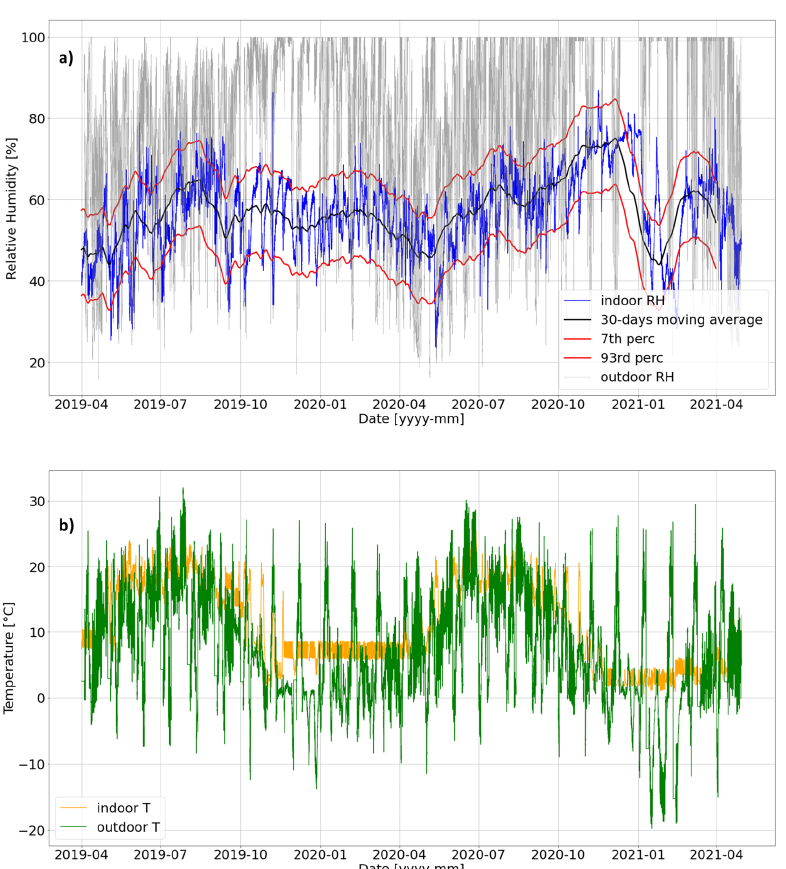
Figure A2. Microclimatic timeseries collected inside and outside Heddal church from the end of March 2019 to the end of April 2021: ( a ) outdoor RH (grey), indoor RH (blue), moving average of RH (black) and percentiles (red) of RH fluctuations computed according to [4]; ( b ) outdoor T (green) and indoor T (orange). Figure A2a shows the measured indoor RH (blue curve), its moving average (MA) calculated over 30 days (black curve) and the 7th (bottom red curve) and 93rd (top red curve) percentiles of the RH fluctuations for Heddal church, calculated according to [3], over two years of observation (from 30 March 2019 to 30 April 2021). In addition, the out- door RH is plotted with a light-grey curve. Figure A2b shows the indoor T (orange curve) and the outdoor T (green curve) in Heddal.